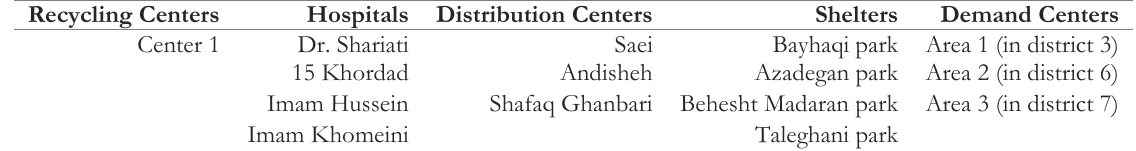
Table 7. Demand areas, shelters and distribution centers, hospitals and recycling centers in the case